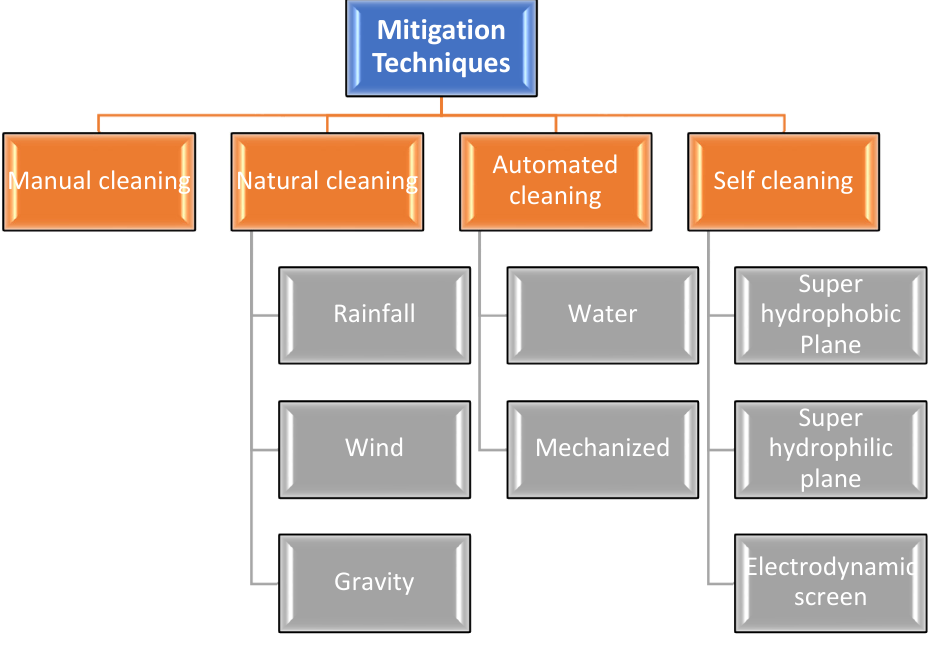
Figure 16. Dust mitigation techniques [69].